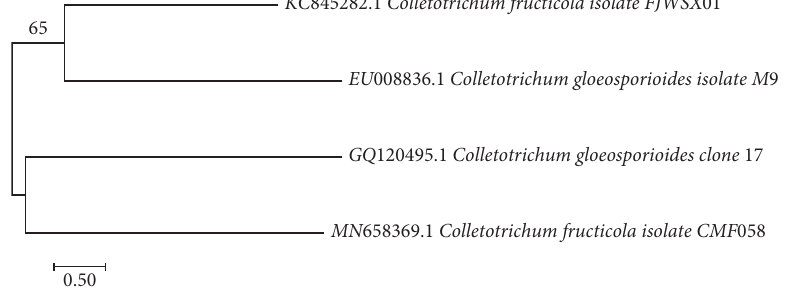
Figure 4: Phylogenetic tree from the sequence of the pathogen isolated from